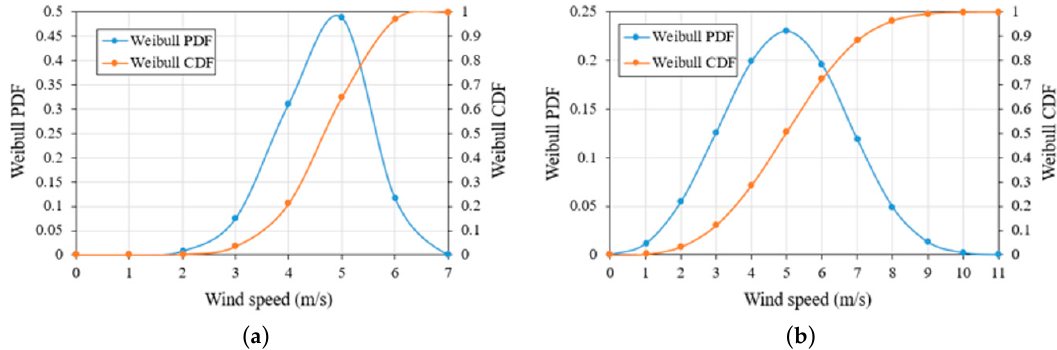
Figure 6. Weibull distribution at 10 m from local ground ( a ) Baengnyeong-do from 2001 to 2016; ( b ) Seo-San from 1997 to 2016.